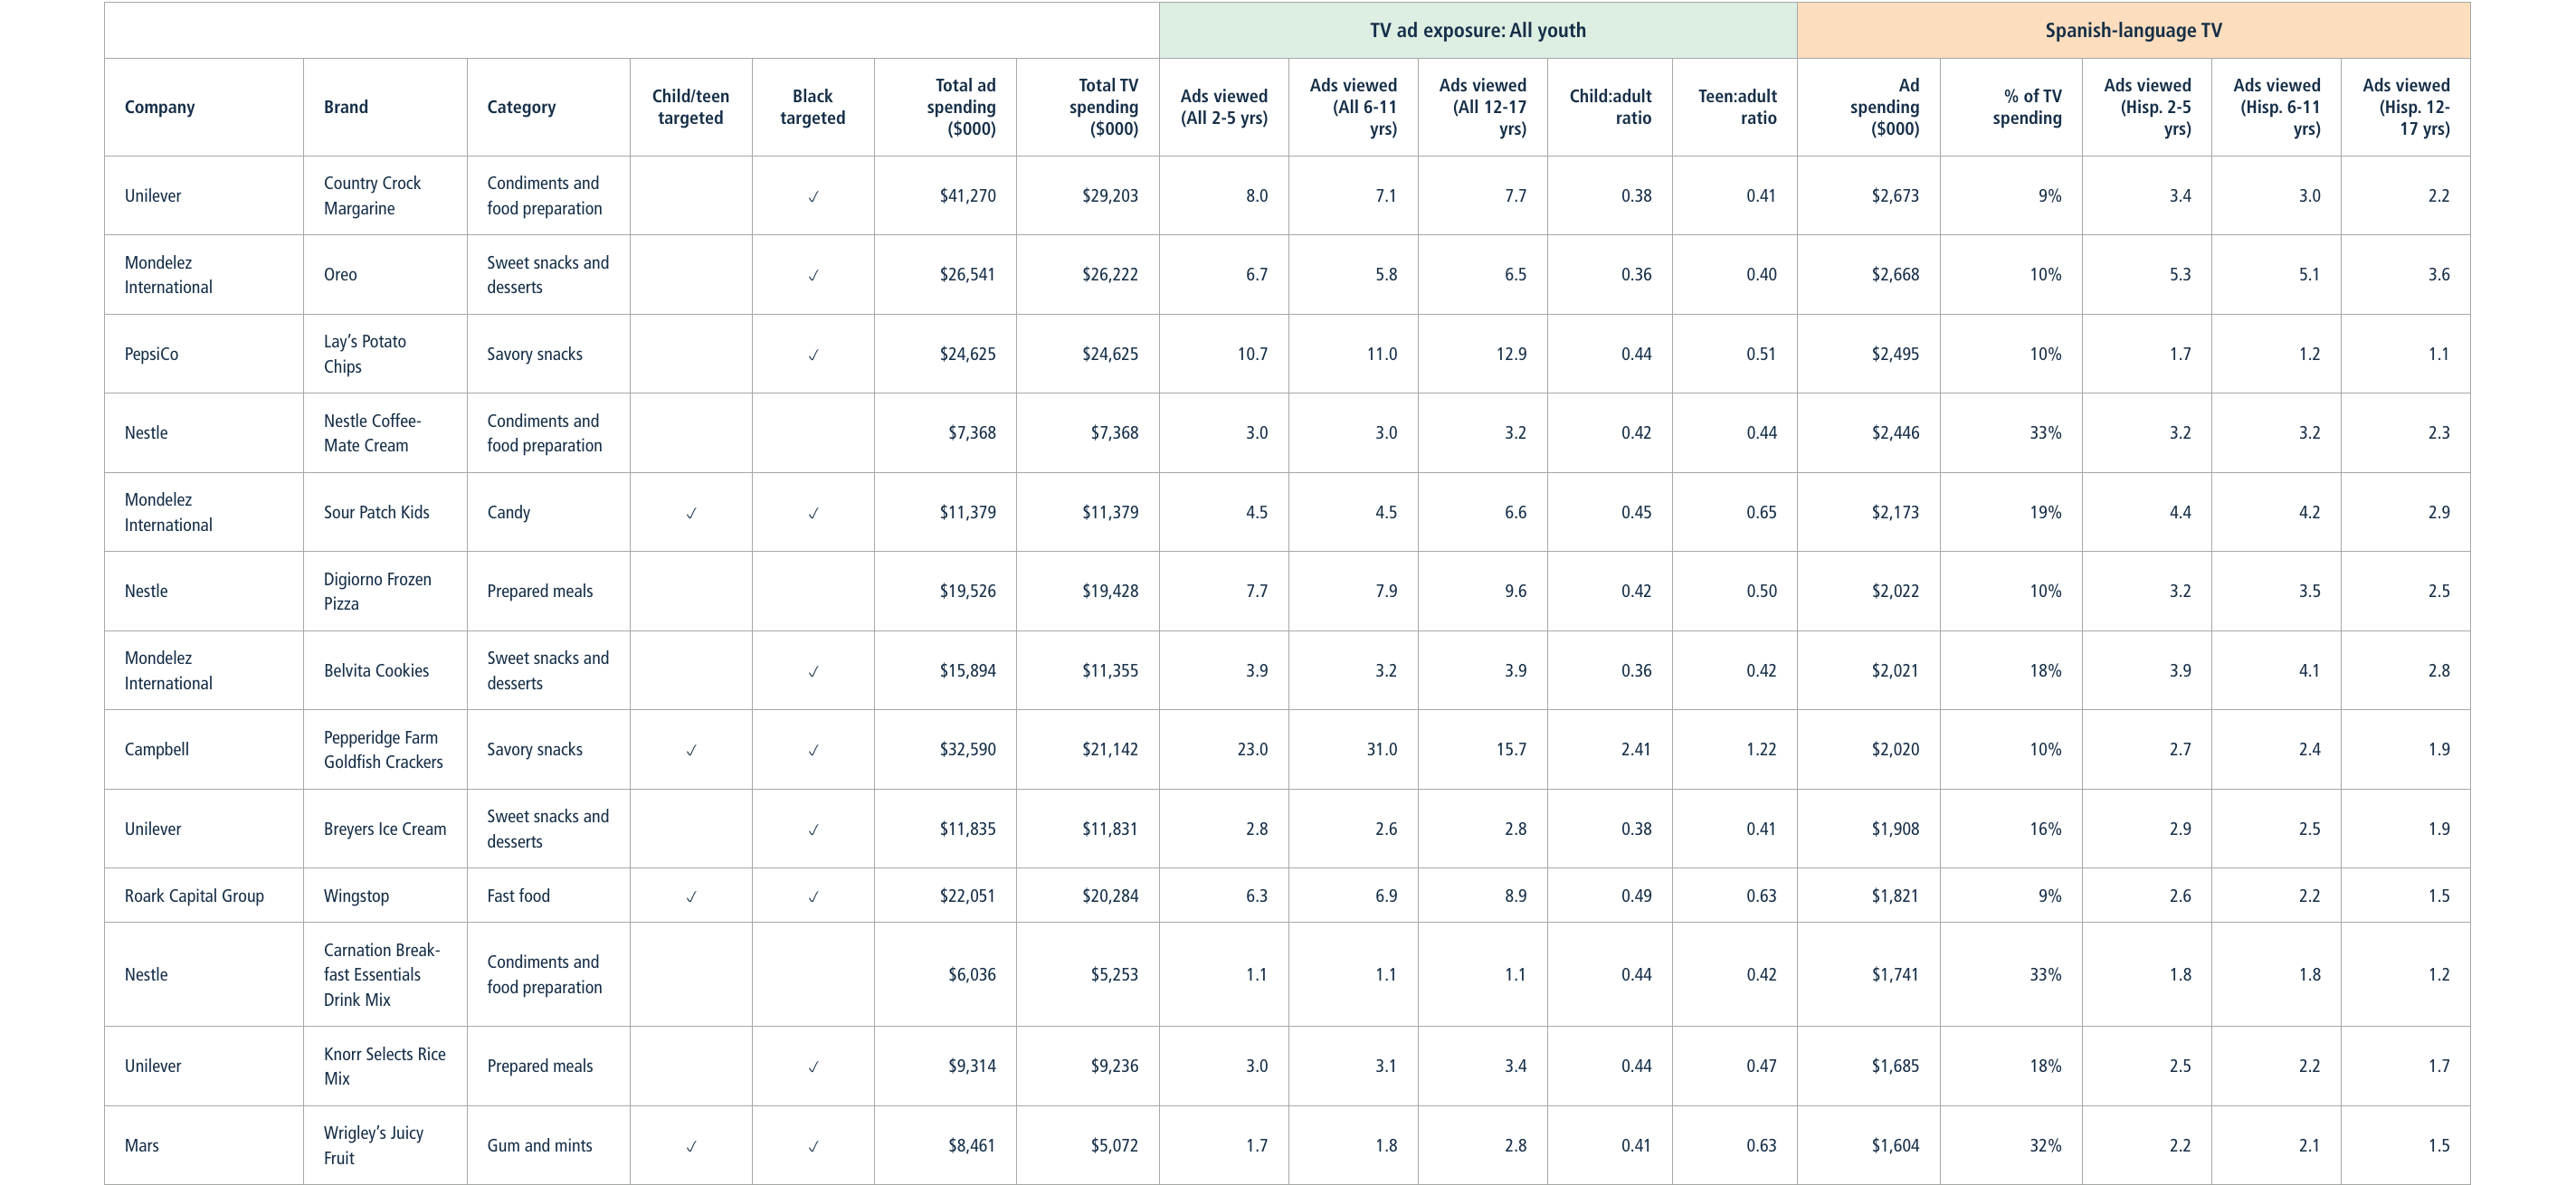
TABLE 2. BRANDS TARGETED TO HISPANIC CONSUMERS